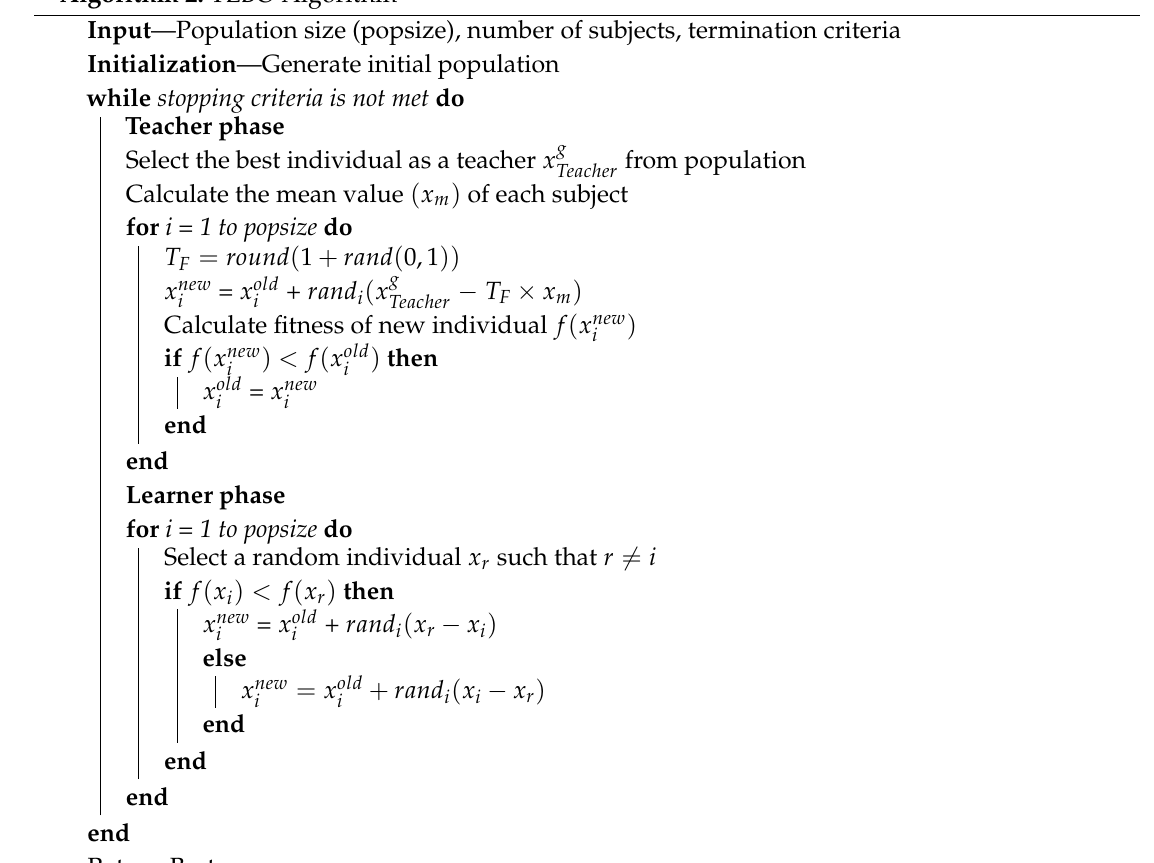
Algorithm 2: TLBO